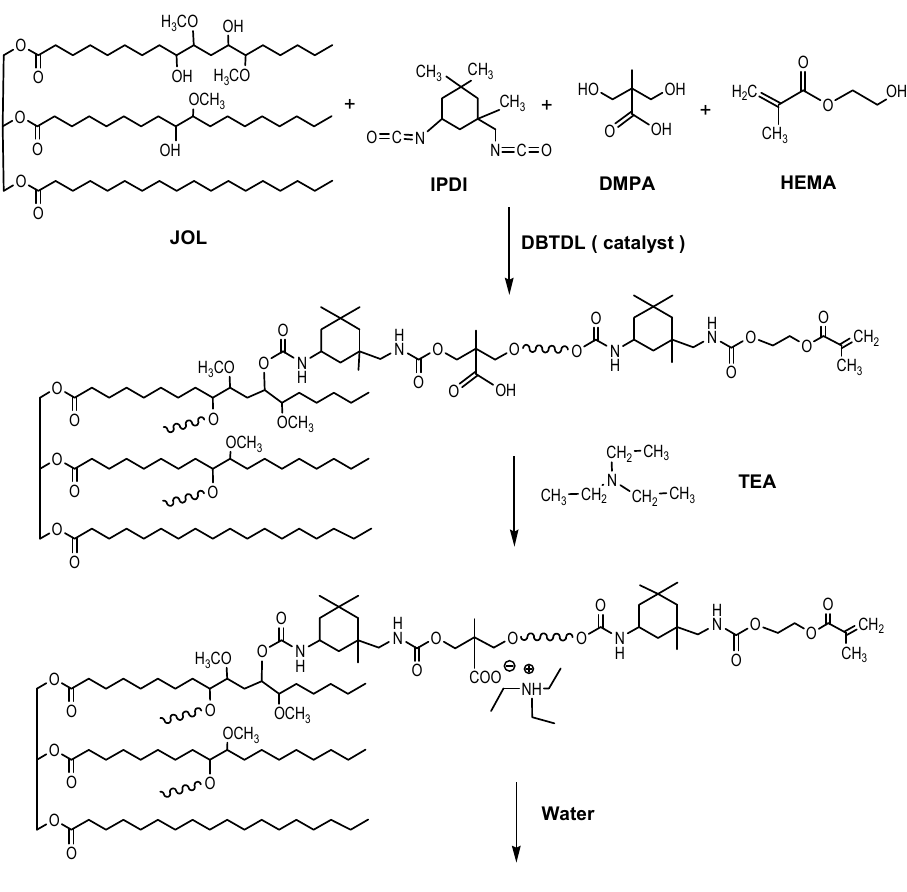
Figure 1. Schematic for the synthesis of Jatropha oil -based waterborne polyurethane (JPU) dispersions. The mixture was heated to 78 ◦ C and stirred for 30 min to obtain a homogeneous mixture. IPDI was then added dropwise for 30 min, followed by a few drops of dibutyltn dilaurate as a catalyst. MEK was added batch by batch to reduce the viscosity of the system. After an additional 3 h of reaction, HEMA was added as a chain terminating agent. The reaction was carefully monitored by FTIR analysis. The disappearance of an NCO peak at 2270 cm − 1 of ATR-FTIR spectra was used as indicator that all diisocyanate was consumed in the reaction. The reactants were then cooled to 40 ◦ C and neutralized by the adding TEA (1.2 equiv. per DMPA), followed by dispersion with distilled water at high